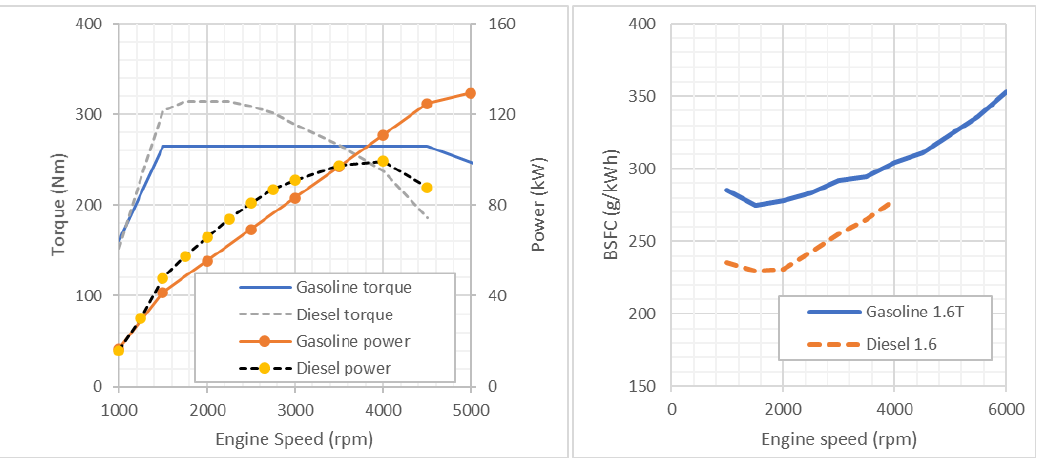
Figure 2. Full load performance and brake specific fuel consumption at TQ = 50.6 and 50.9 Nm (Gasoline/Diesel) .